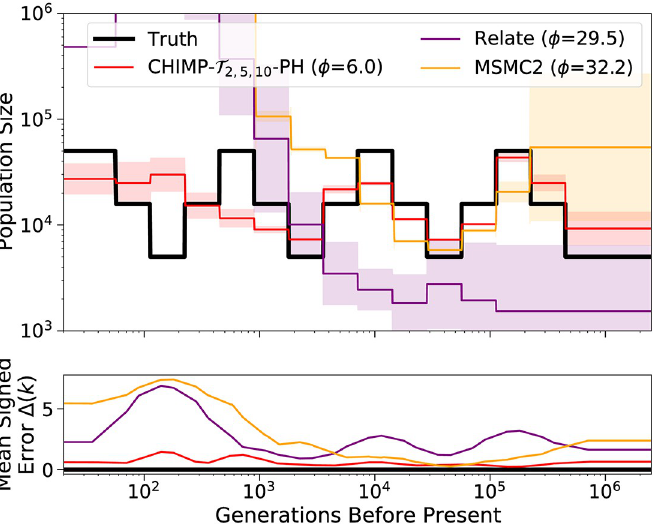
Fig 10. Results of inference using 10 pseudo-haploids simulated under the piecewise sawtooth demography. We compare the results of CHIMP - T using the pseudo-haploid option, MSMC2 , and Relate , fixing the change points 2 ; 5 ; 10 to match the truth (shown in black). Solid lines are averages over 16 replicates and shaded area indicates standard deviation. Mean signed error Δ ( k ) is shown in bottom plot and has been smoothed using moving average for visualization purposes. The integral ϕ is indicated in the legend. Note that Relate entirely failed to estimate a population size in the most recent epochs, resulting in indeterminate values.